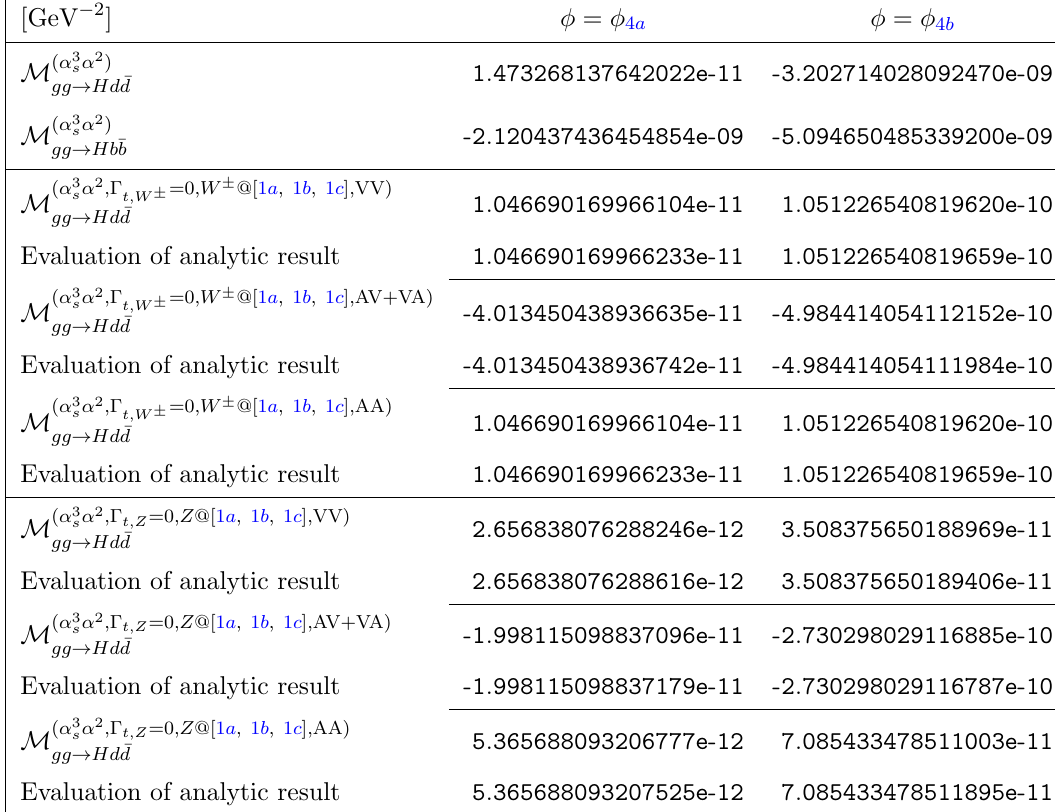
Table 5 . Benchmark evaluations of various matrix elements comparing numerical results from MadLoop against an independent analytical derivation of the amplitude, presented in appendix B (see text for